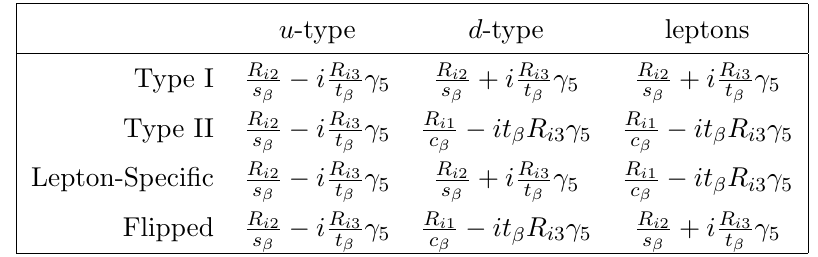
Table 2 . Yukawa couplings of the Higgs bosons H i in the C2HDM, divided by the